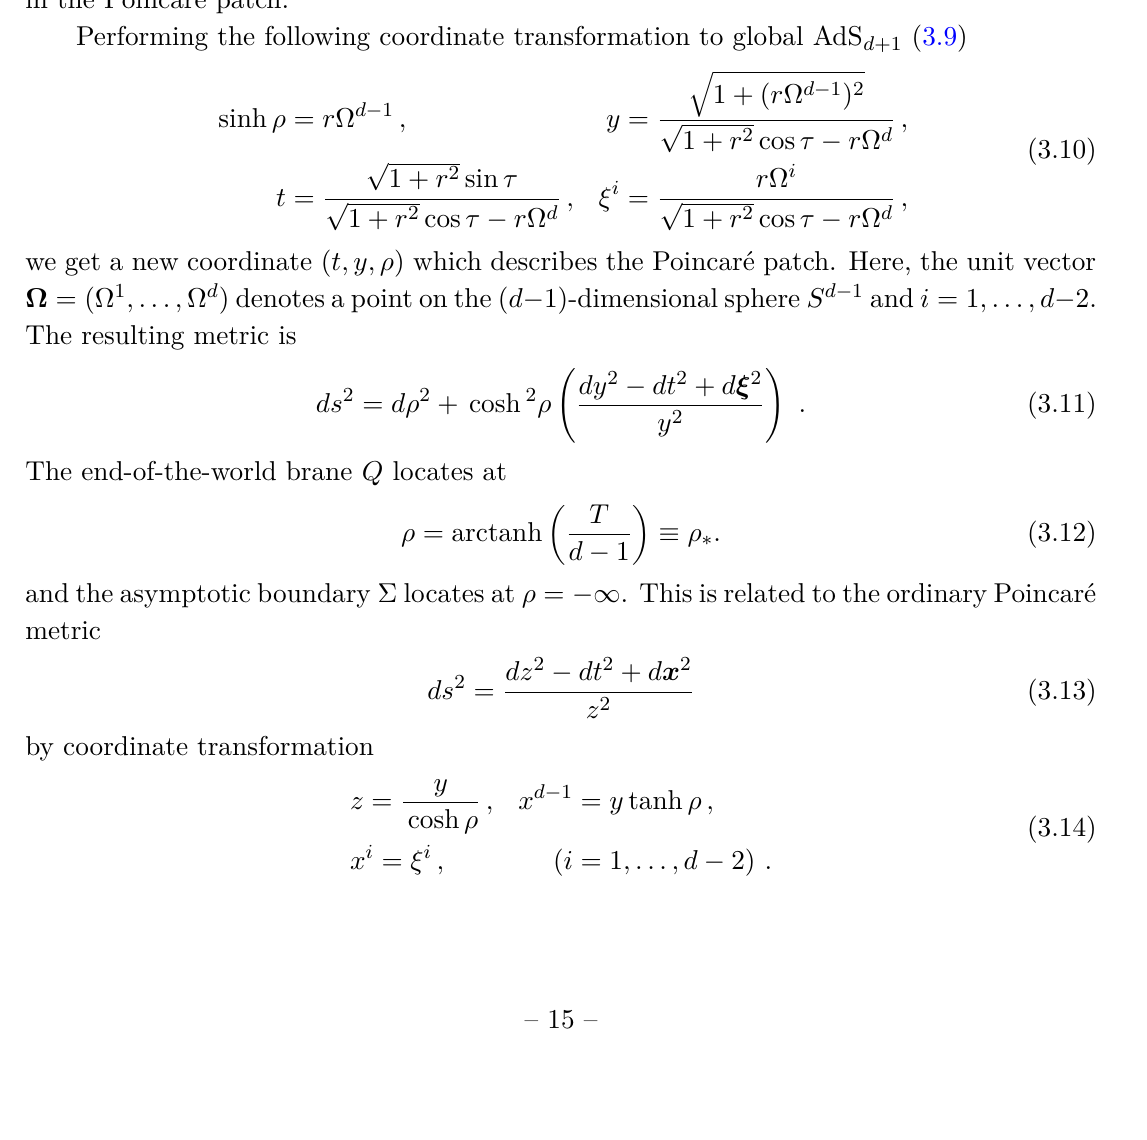
Figure 6 . Poincaré patch in global AdS 3 . The shaded region shows the Poincaré patch. simple in it. We will give the time advance by explicitly writing down the null geodesics in the Poincaré